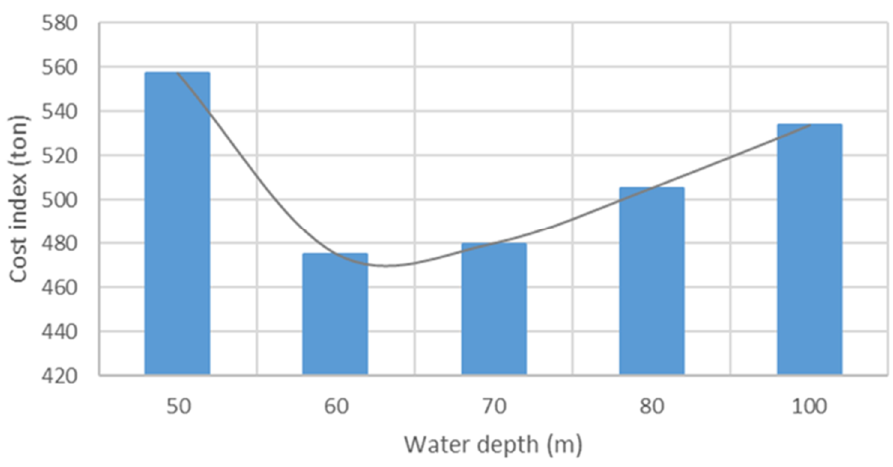
Figure 13. Hardware mooring cost for the different water